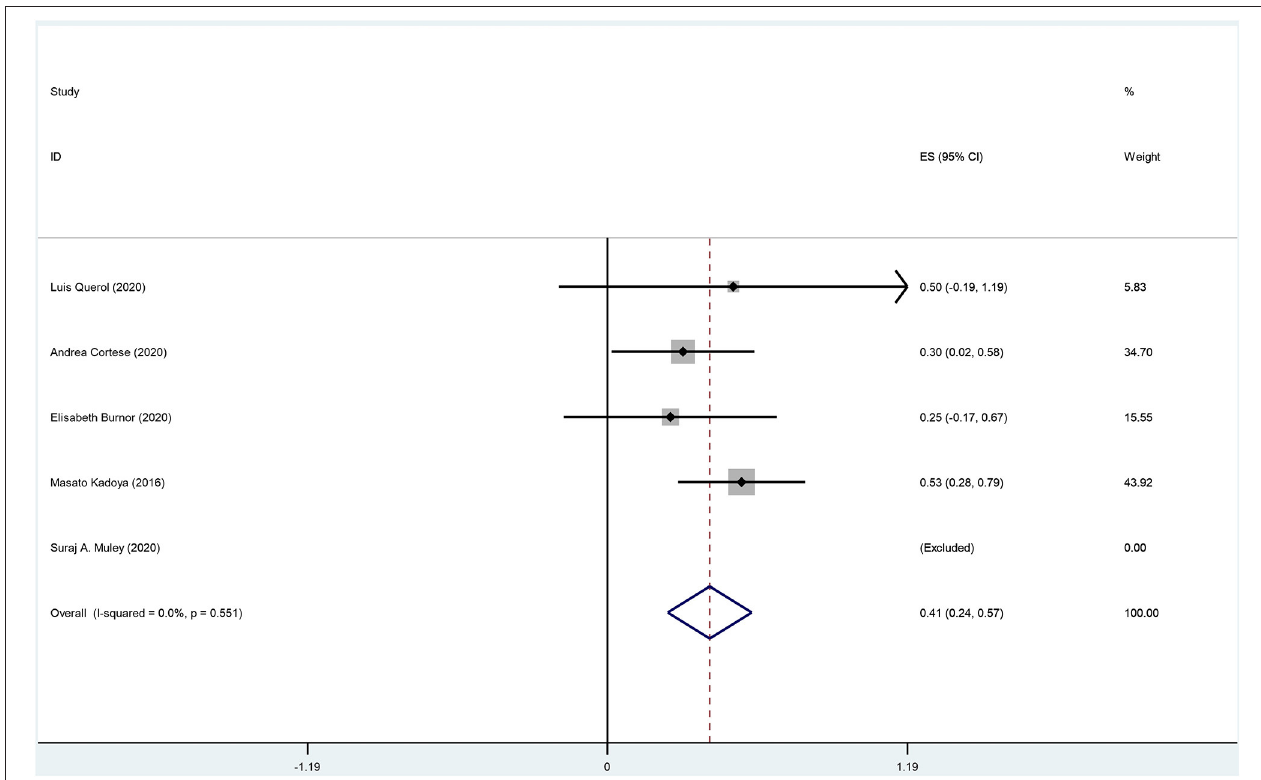
FIGURE 7 | The forest plot of incidence of